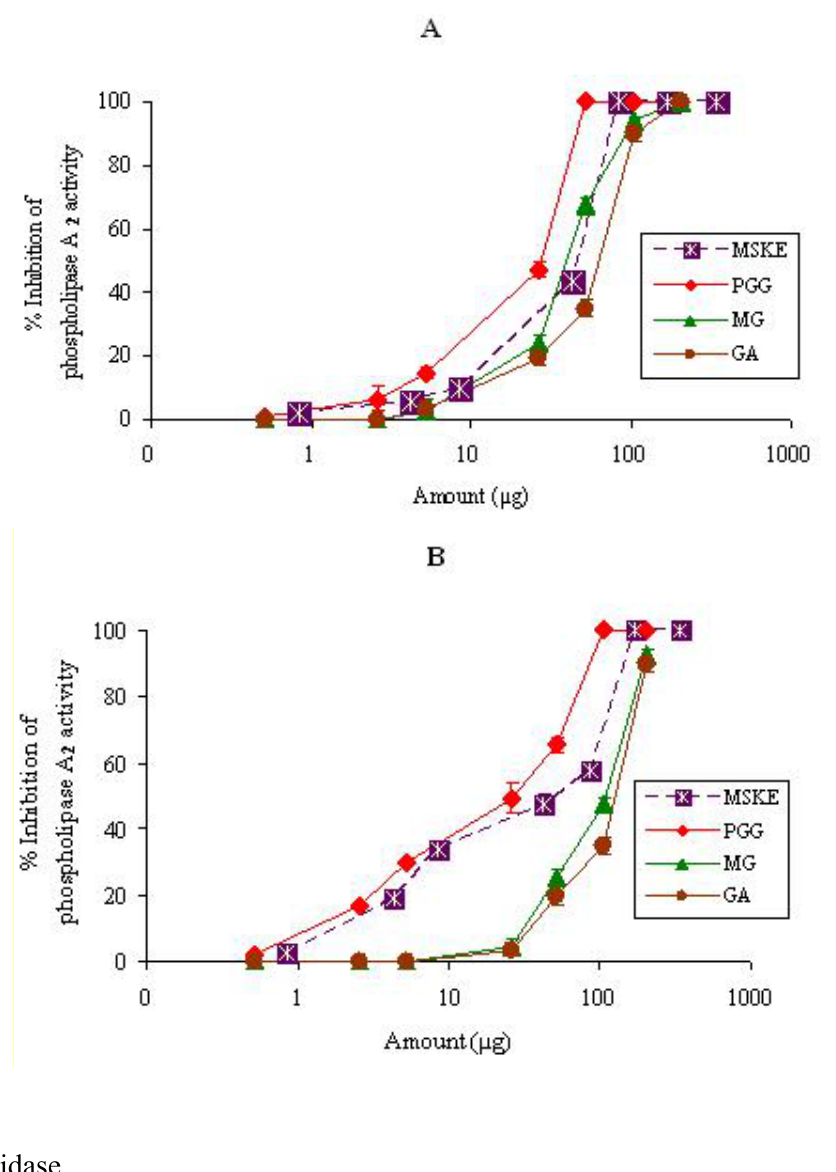
Figure 1. Semi-log plot of inhibition of PLA µg) (B) venoms by MSKE and its phenolic principles (GA, MG and PGG). Values are mean ± S.E.M. of duplicate